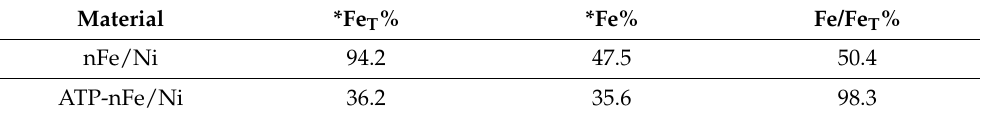
Table 2. Percentage of Fe/Fe T in nFe/Ni and ATP-nFe/Ni. Material